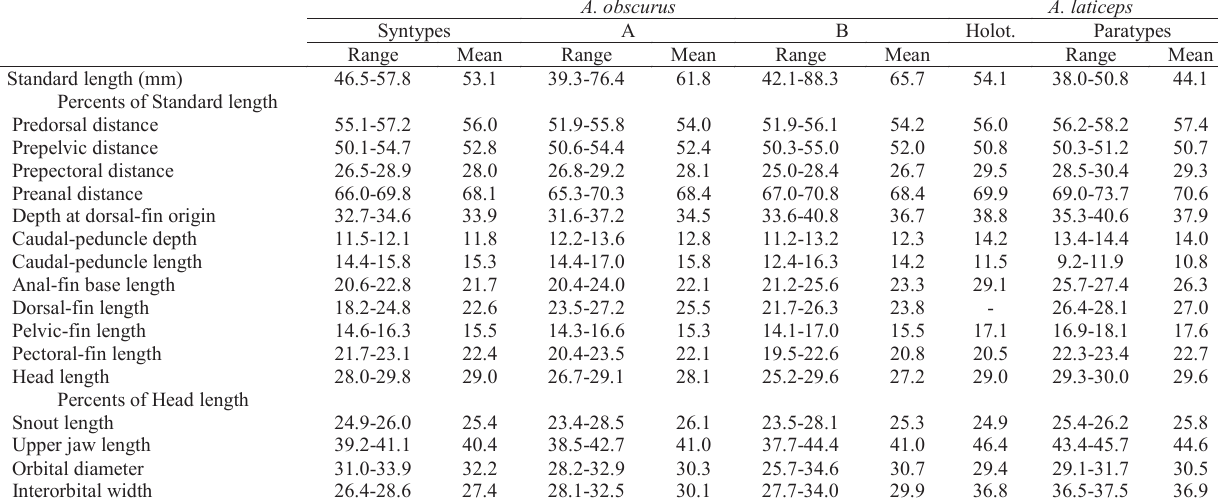
Table 1. Morphometric data of Astyanax obscurus : syntypes (ZMB 7478, n = 3), and non-type specimens from rio Cadeia, tributary of rio Caí (A, n = 21), and from rio das Antas, rio Jacuí drainage (B, n = 33); and Astyanax laticeps : holotype (ANSP 21852), and paratypes (ANSP 21743, n = 4), Rio Grande do Sul, Brazil.